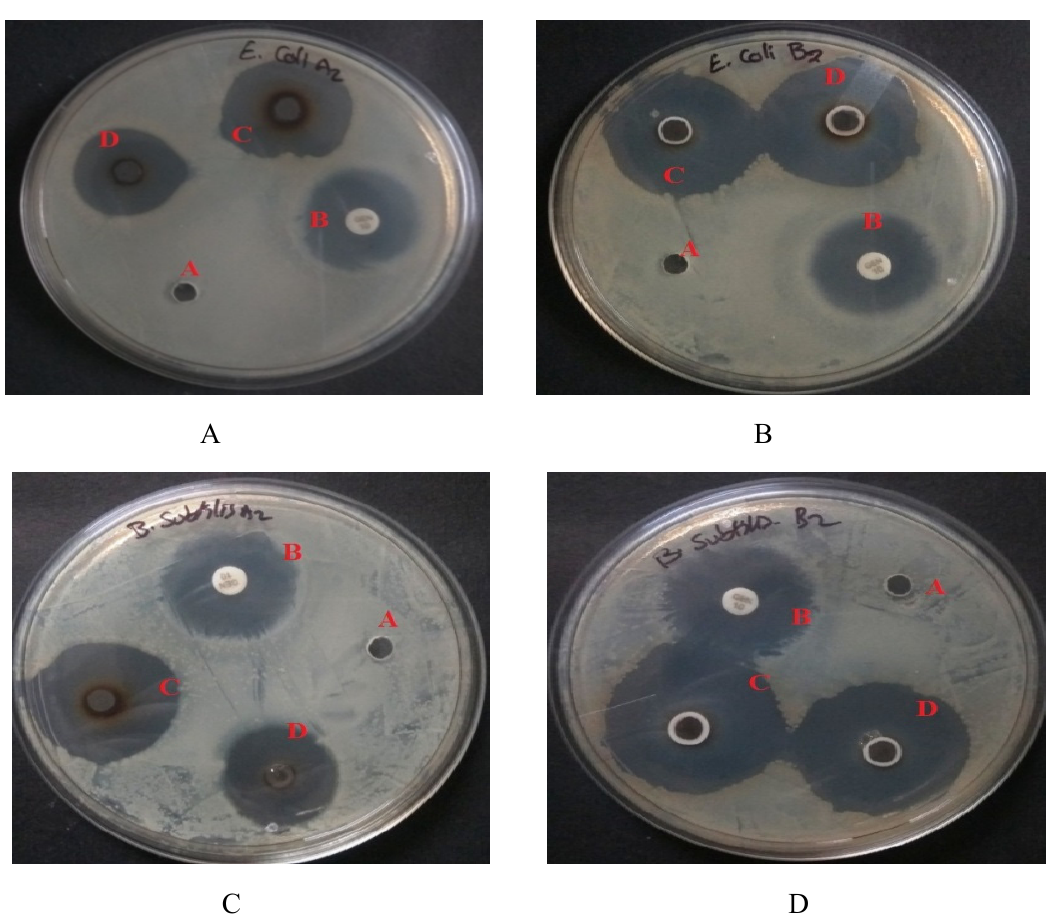
Fig. 6. Antibacterial activity of AgNPs. A& B. AgNPs prepared using leaf and stem extracts of L. glutinosa applied on E. coli culture plates. C & D. AgNPs prepared using leaf and stem extracts of L. glutinosa applied on B. subtilis culture plates.